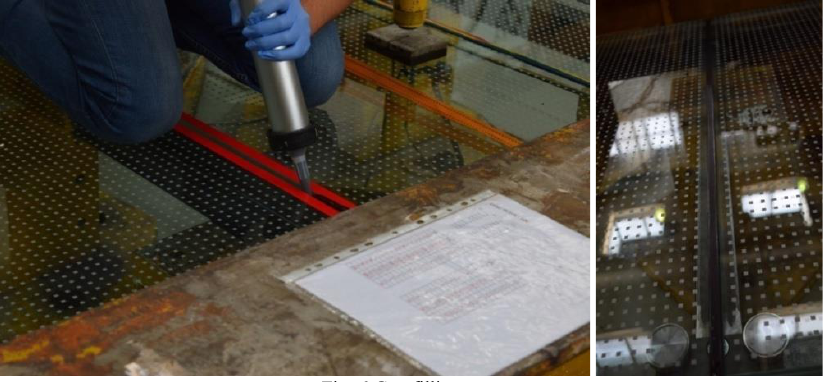
Fig. 6 Gap filling